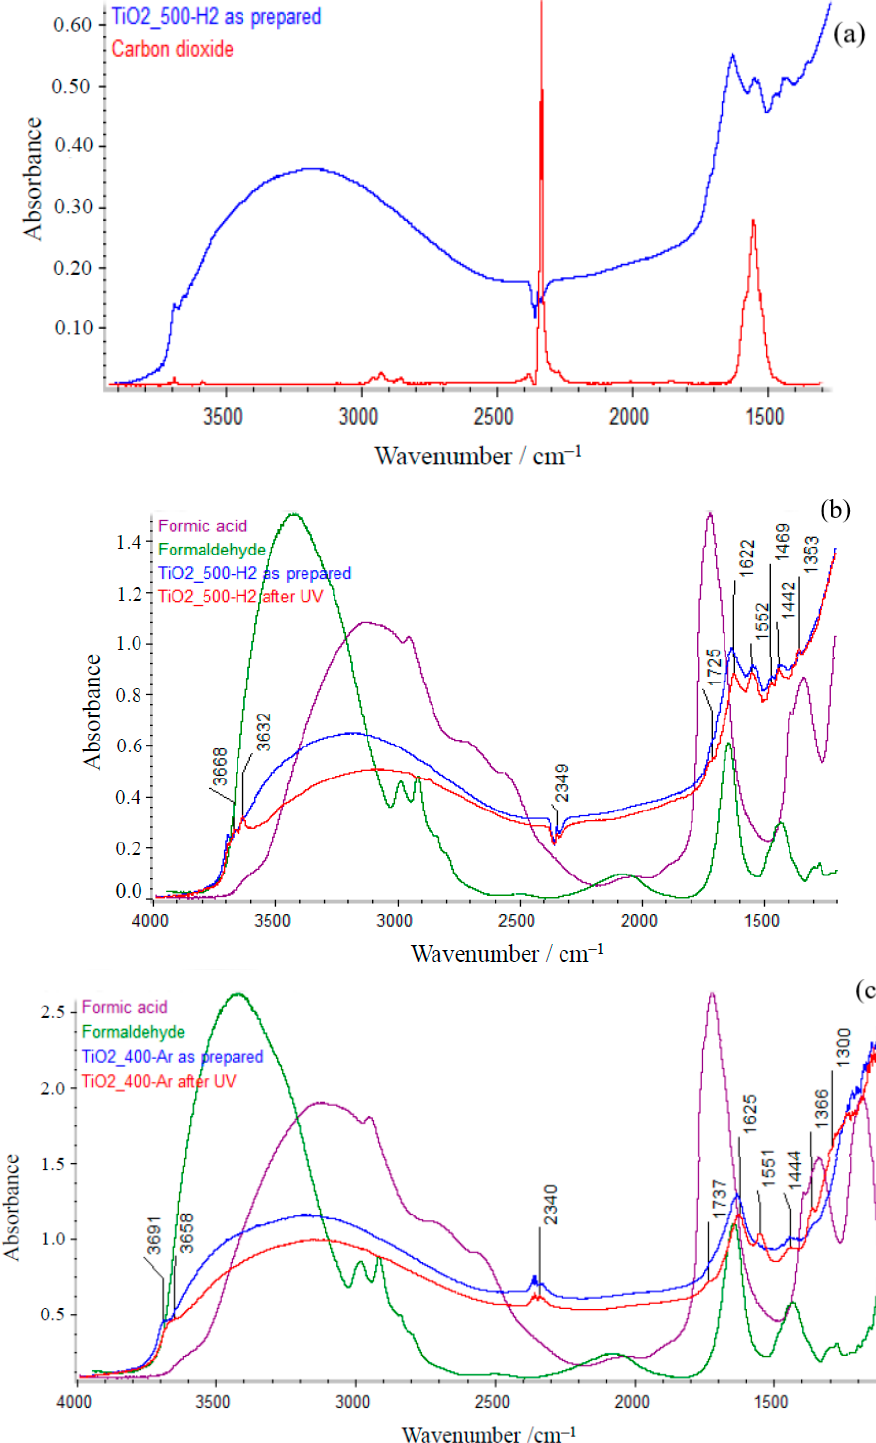
Figure 9. FTIR spectra from the in situ measurements of ethylene decomposition under UV irradiation with comparison of selected IR spectra patterns of iced CO 2 , formic acid and formaldehyde, ( a ) TiO 2 _500-H 2 as prepared, ( b ) TiO 2 _500-H 2 before and after UV irradiation and ( c ) TiO 2 _Ar-400 before and after UV irradiation.